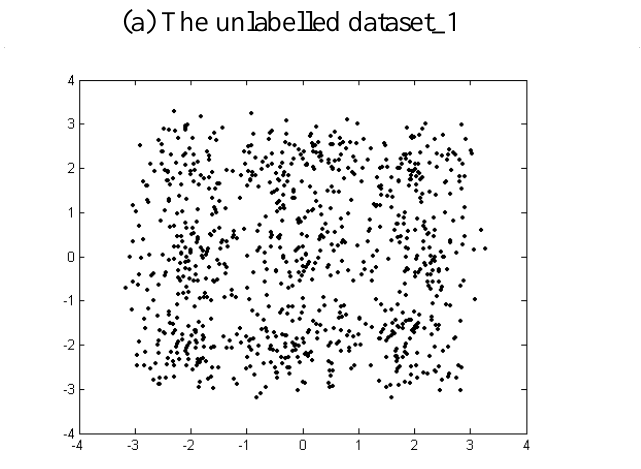
Figure 4. Clustering result for artificial